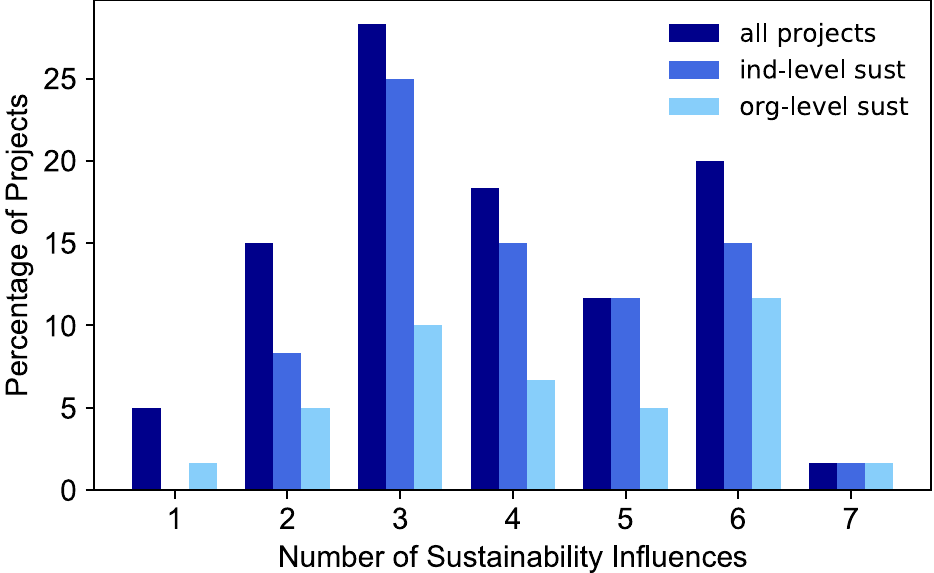
Fig 5. Percentage of projects with a certain number of sustainability influences and sustainability level achieved. The funded CDI projects are grouped in categories 1) all projects (dark blue), 2) projects achieving individual-level sustainability (medium blue), and 3) projects achieving organization-level sustainability (light